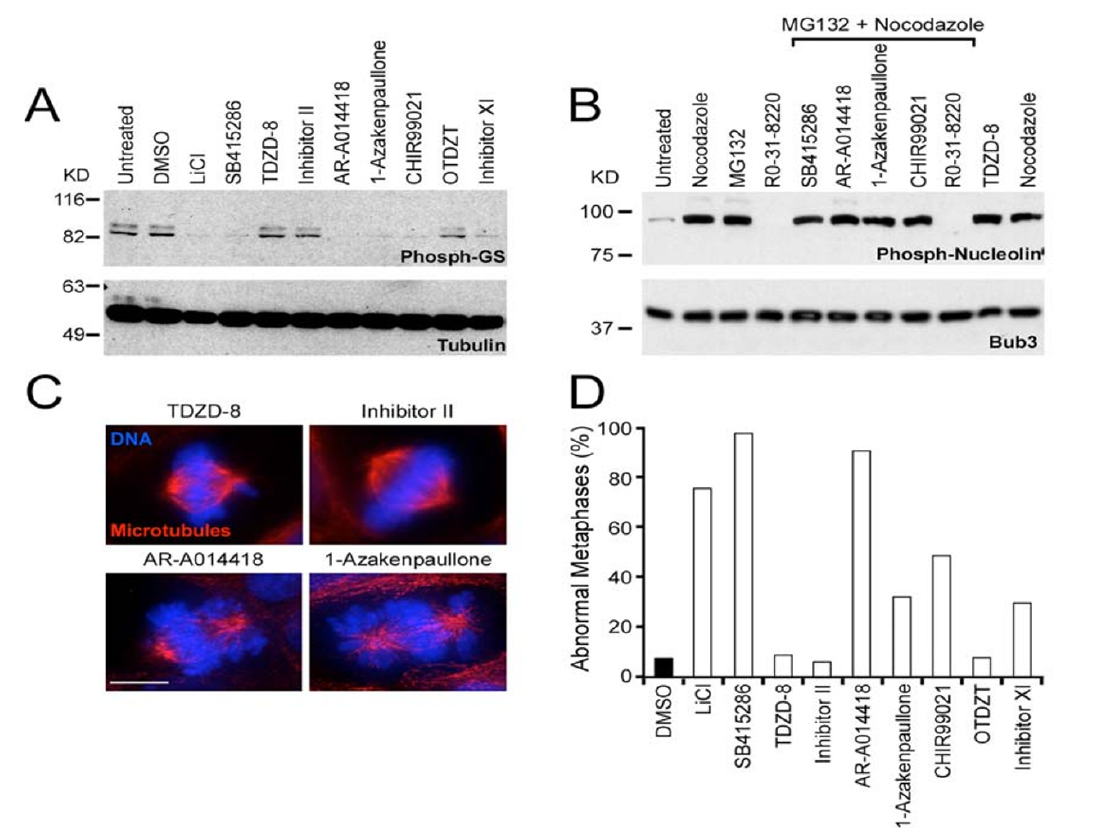
Identification of small molecules which inhibit GSK-3 in vivo Figure 2 showing examples of abnormal metaphase spindles following exposure to AR-A014418 and 1-Azakenpaullone. ( D ) Bar graph plotting the number of abnormal metaphases in cells treated with different small molecule GSK-3 inhibitors.